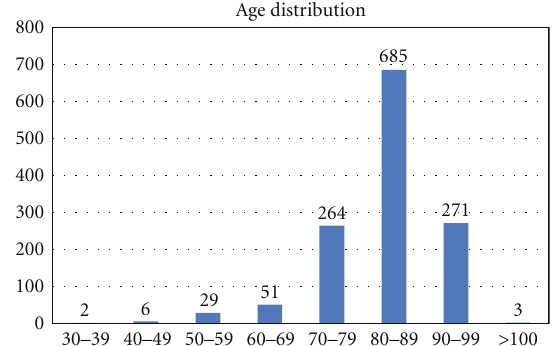
Figure 2: Age distribution of patients admitted to hospital from nursing homes in the city of Bergen, Norway, during the period from March 2006 to March 2007 ( N =